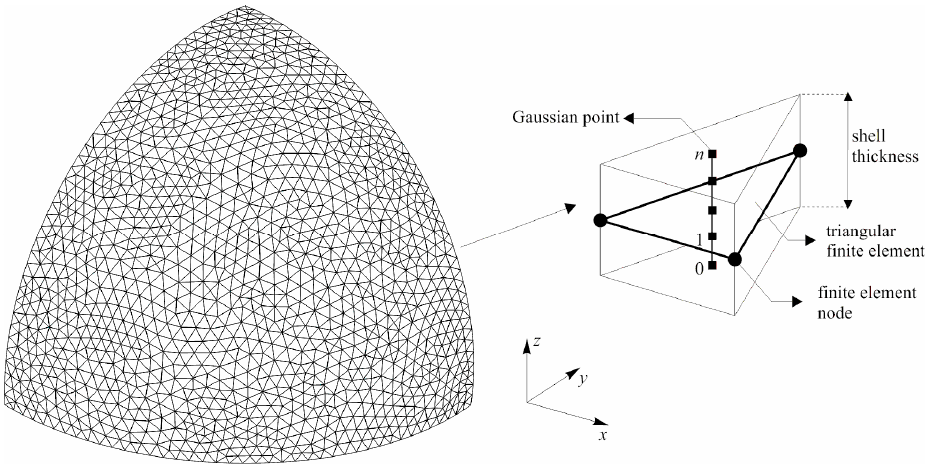
Figure 1. Discretisation of shell structure.